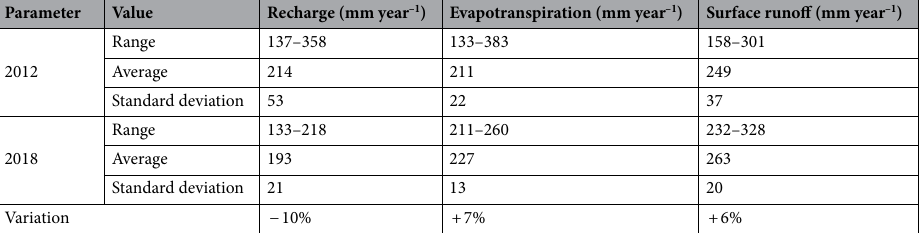
Table 5. Annual water balance components in the Drava floodplain under built-up areas from 2012 to 2018.